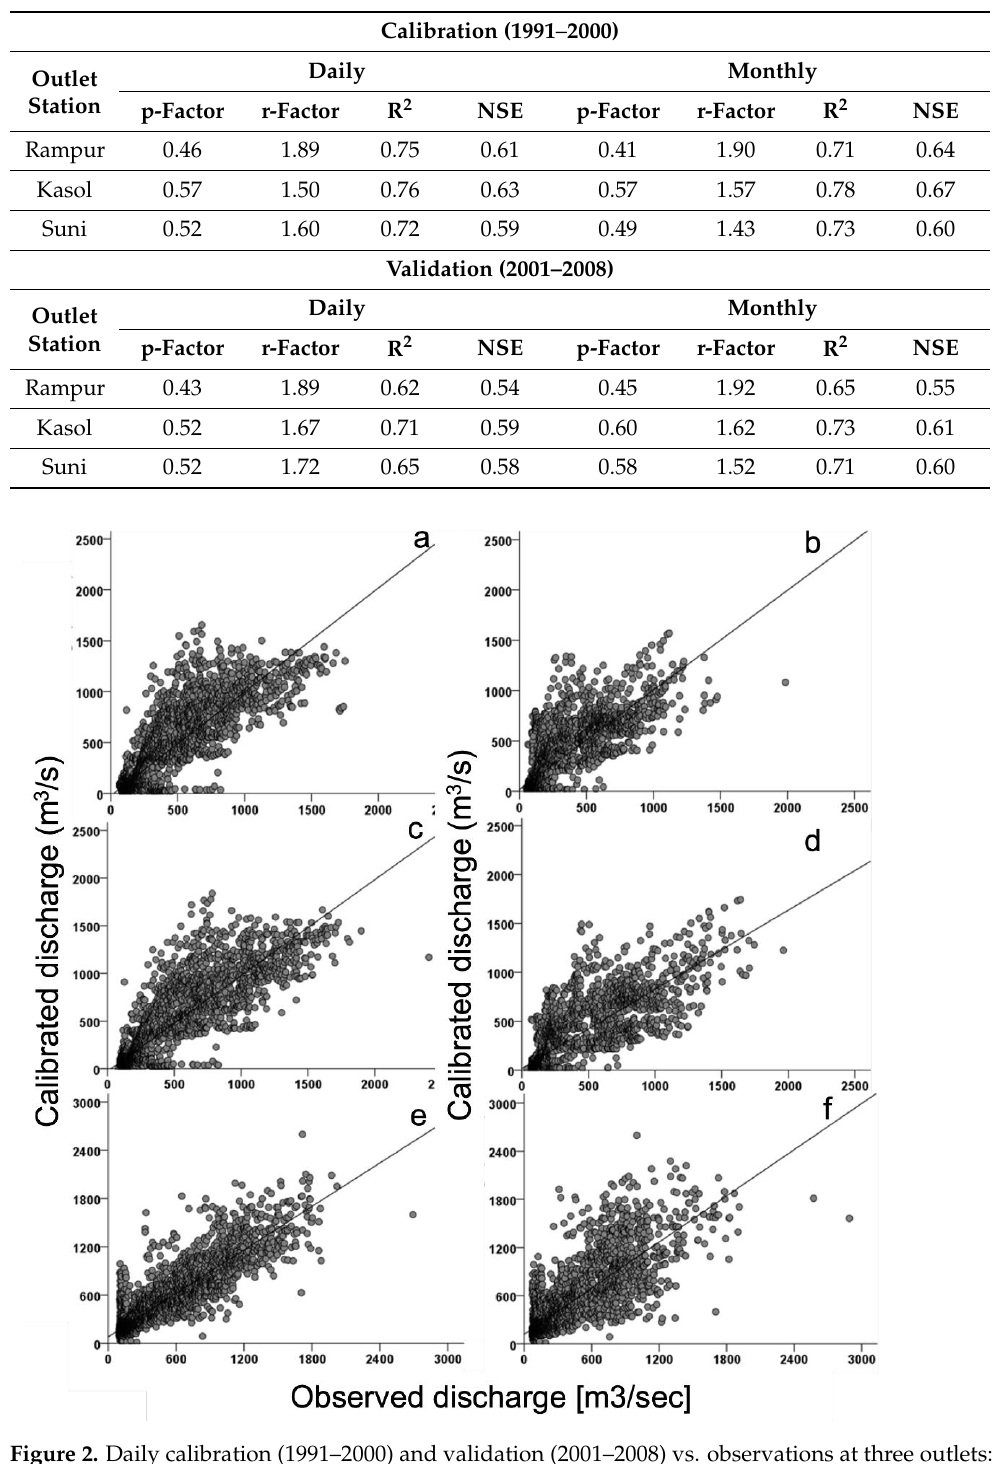
Table 2. Model calibration and validation results as per SUFI method on the daily and monthly basis analysis.